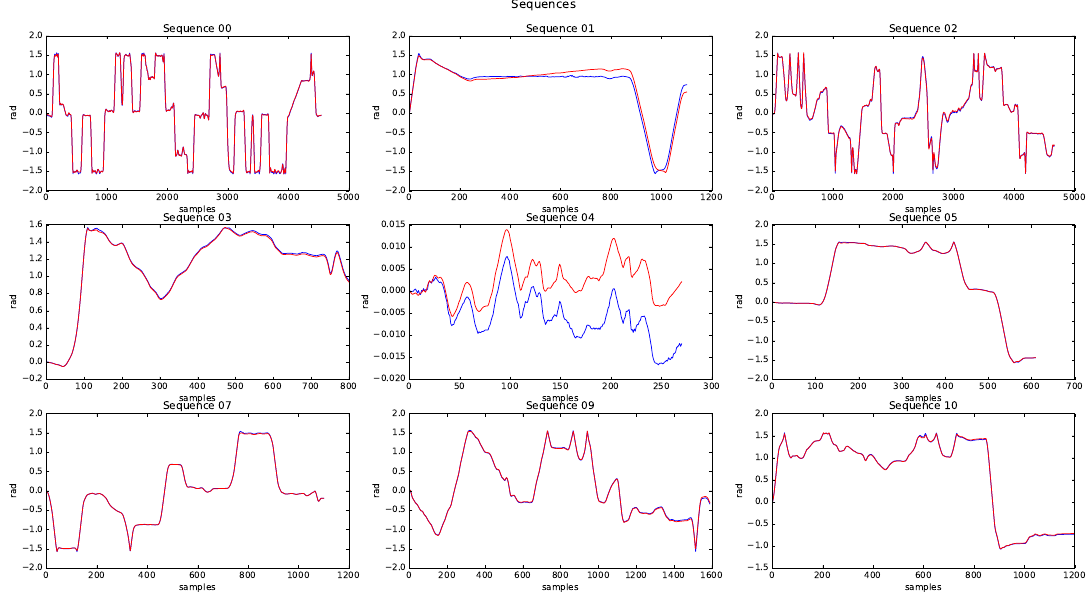
Figure 25. Heading sequences